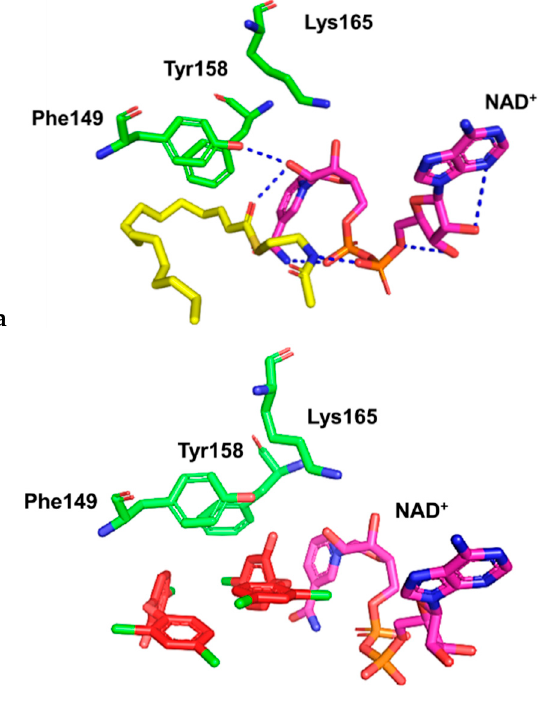
Figure 2. ( a ) A representation of the interaction of a C16 fatty acyl substrate (yellow) with the InhA active site residues (green) and the cofactor NAD + (magenta), H-bonds (blue) (from PDB.1BVR) [29]. ( b ) A view of the key interactions of two molecules of TCS within the active site. TCS molecules (red), the active site residues (green) and NAD + (magenta) (PDB.1P45). The two TCS molecules are separated by a distance of 4.6 Å between the two carbons attached to the B-ring para - chlorine atoms.